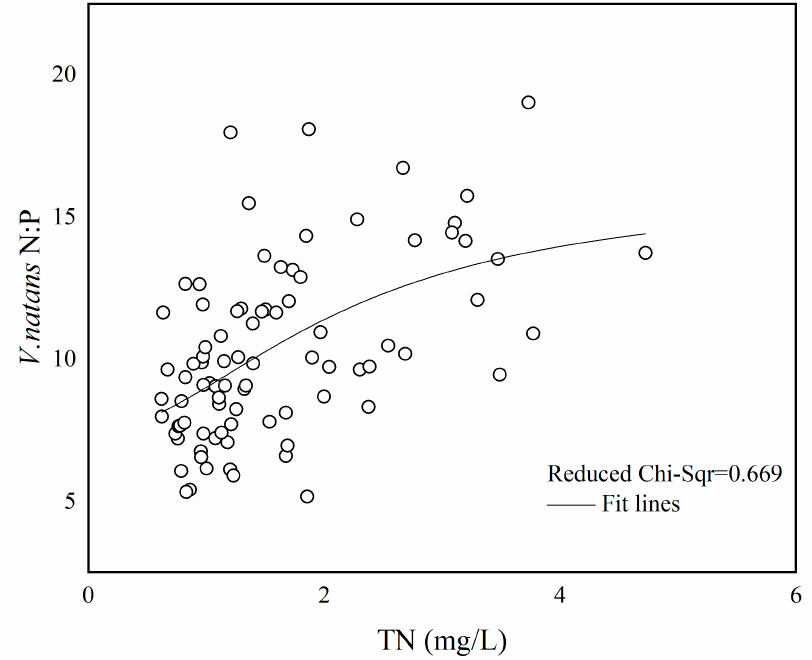
Figure 8. The relationship between V. natans N:P and water TN. Table 9. Summary of the best model of the relationship between V. natans C:P and water N:P. Predictor Coefficient Std. Error